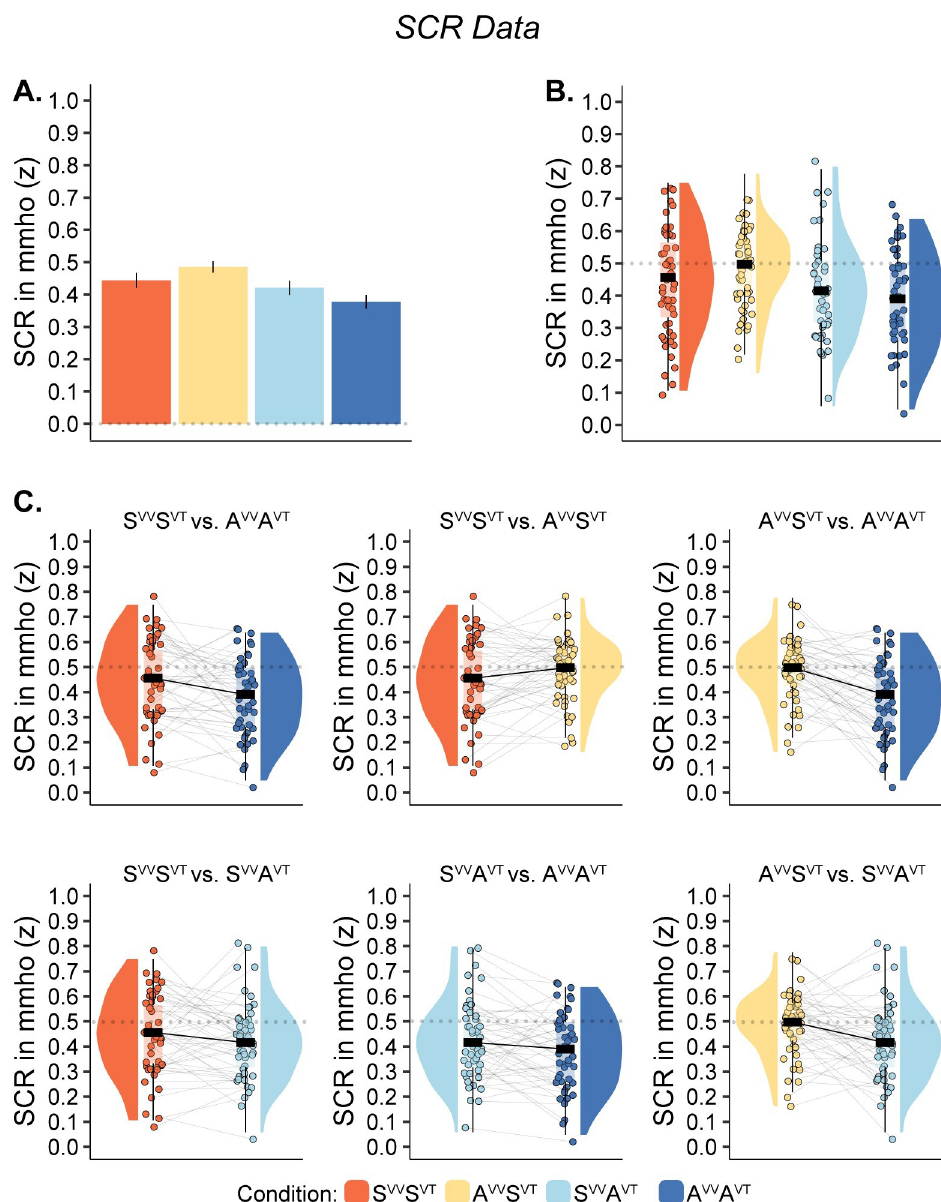
Fig 4. Plots show normalized SCR magnitude data (N = 50). ( A ). Barplot shows means and standard errors for illustrative purposes. ( B ). Raincloud plots show individual data points and medians. ( C ). Raincloud plots for SCR magnitude data. Individual data points, medians, paired lines, and distributions are